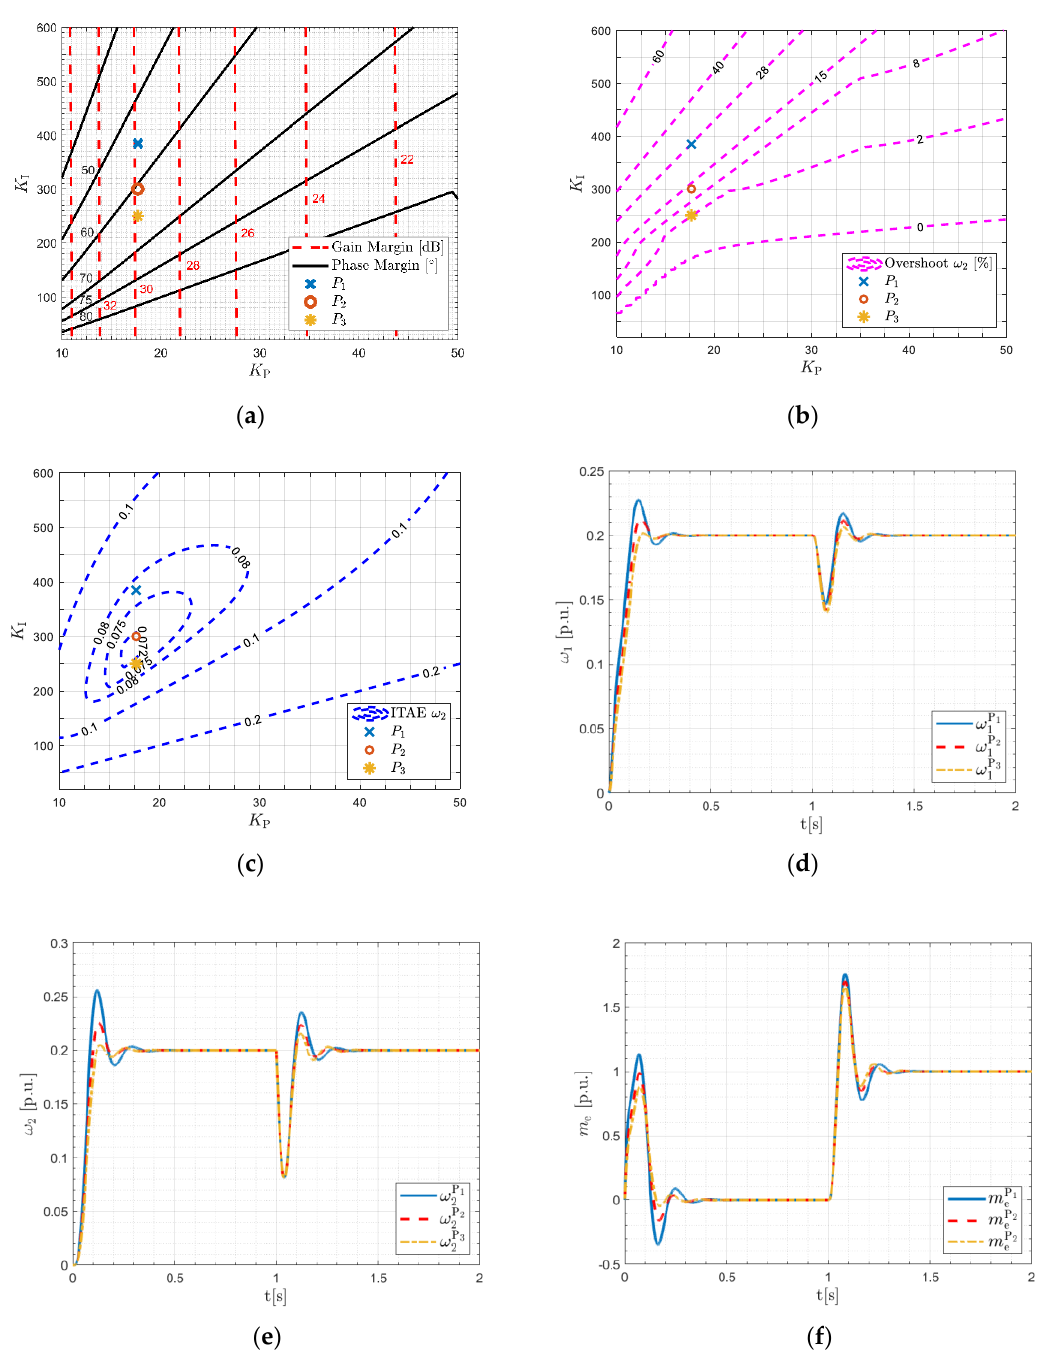
Figure 7. Characteristics of the system: stable region of work ( a ), overshoot in ω 2 ( b ), value of ITAE for ω 2 ( c ) transients of motor speed ω 1 ( d ), load speed ω 2 , ( e ) and shaft torque m s ( f ).